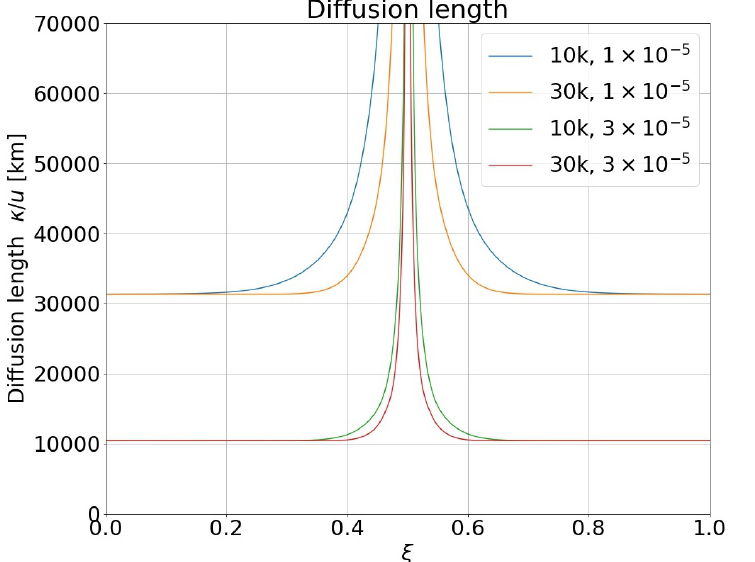
Figure 9. The calculated energetic particle diffusion lengths for simulations of coronal loops with the sizes L = 10,000 km and L = 30,000 km. The 30,000 km loop α = 3 × 10 − 5 simulation has a spatial cell size ∆ x = 5 km and the rest have a spatial cell size ∆ x = 20 km. The loop lengths in kilometers and normalization values for the curves are displayed in the legend in the mentioned